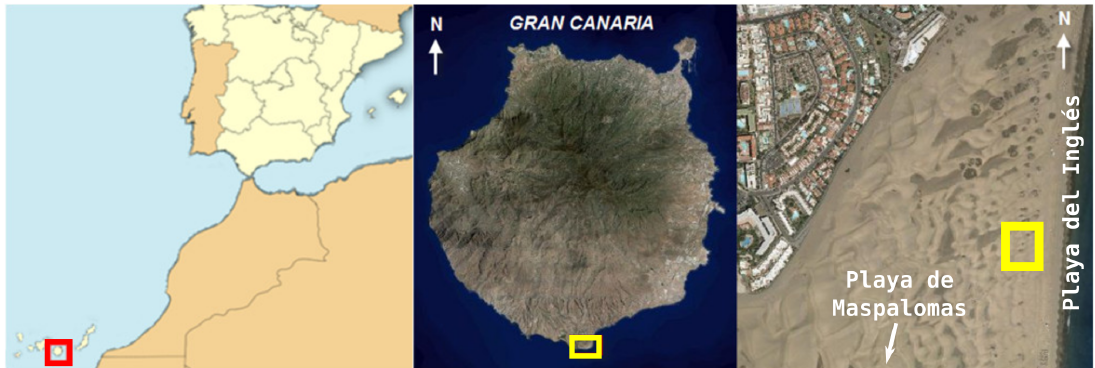
Figure 8. Study area and experimental site location (right-hand image, in